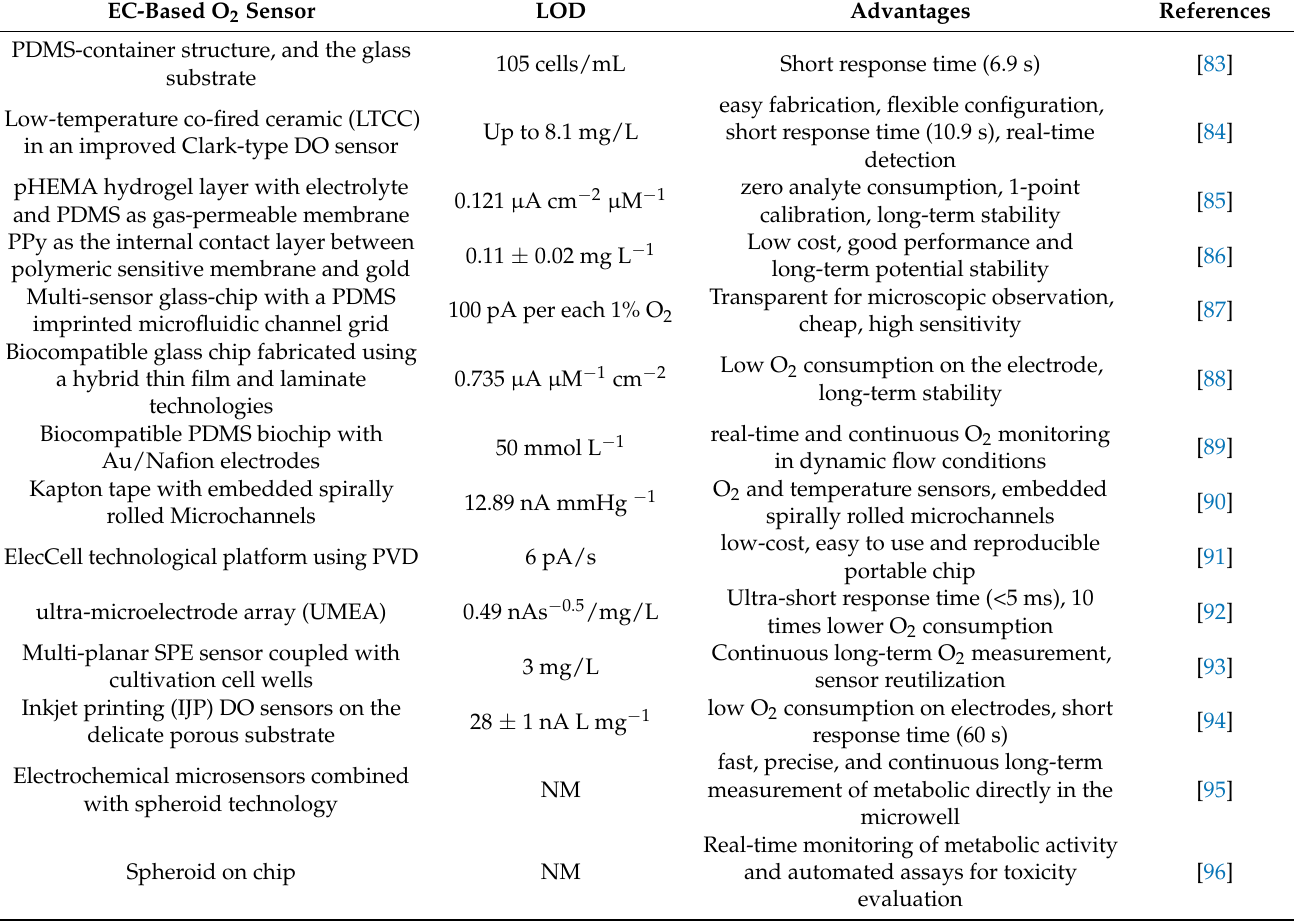
Table 3. Characteristics of chip-based electrochemical O 2